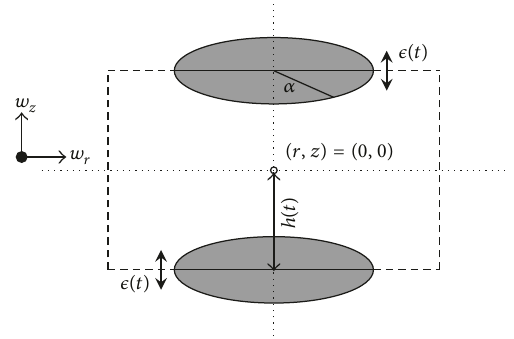
Figure 1: Geometrical interpretation of squeezing